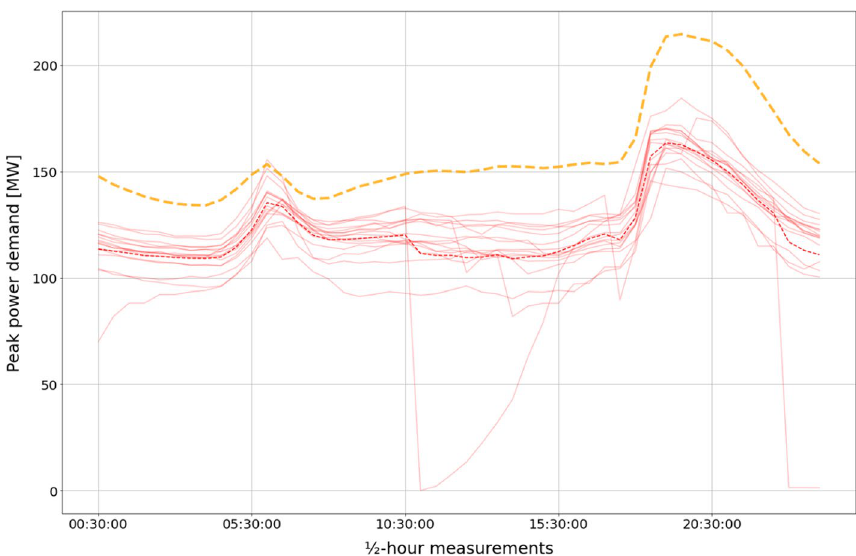
Fig. 25 The load profiles in cluster 2 (16 samples in total) for Lombok in 2018 (Note: The red, solid lines specific daily profiles; The red, dashed line the average load profile for that specific cluster; The thick, = = orange, dashed line the average daily load profile of the entire =